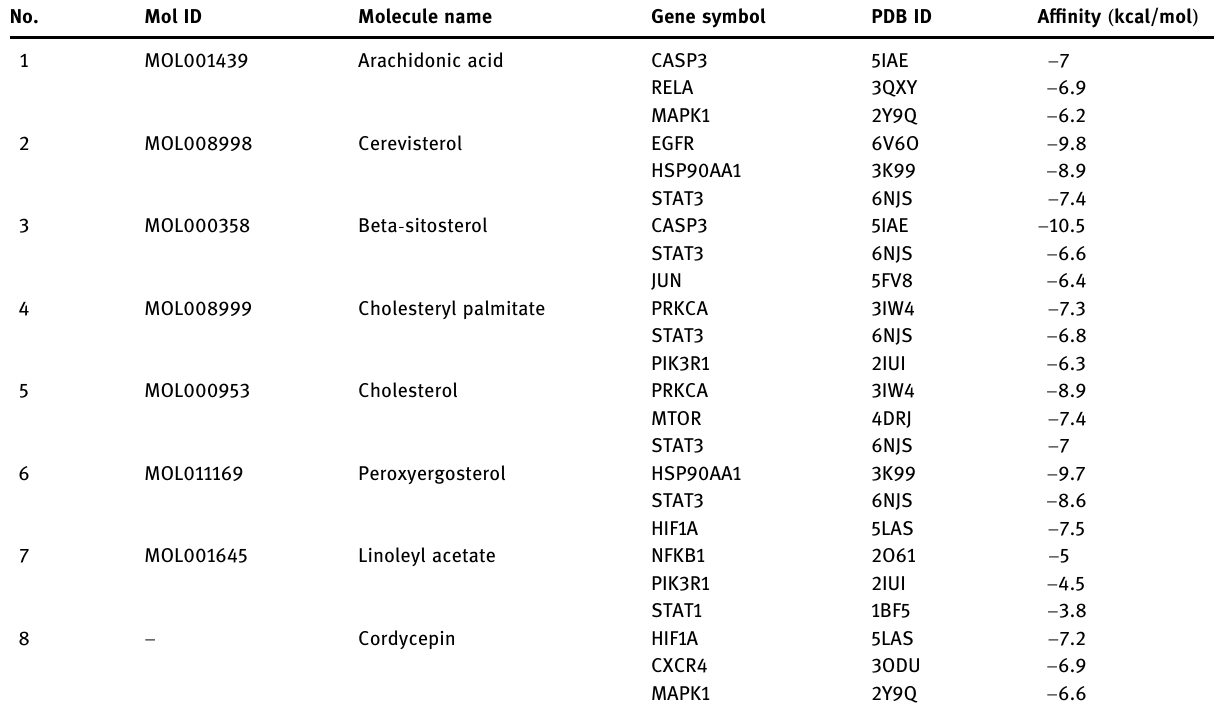
Table 5: Molecular docking results of the active components and key targets